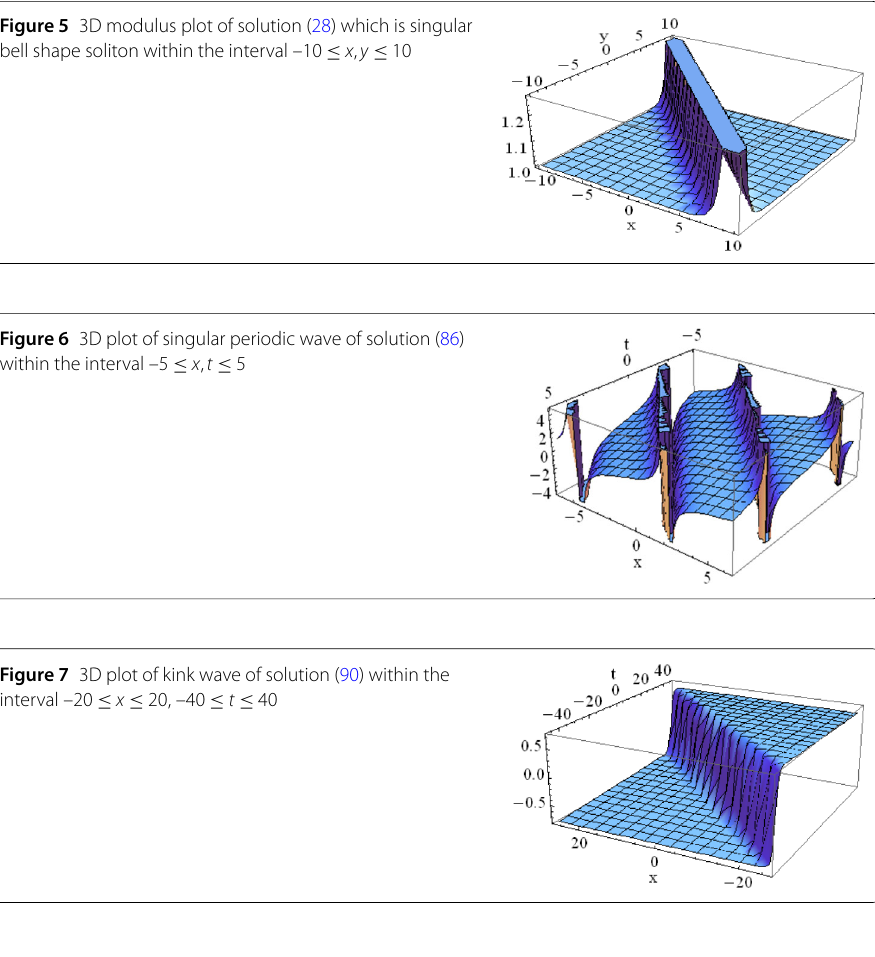
Figure 5 3D modulus plot of solution (28) which is singular bell shape soliton within the interval –10 ≤ x , y ≤ 10